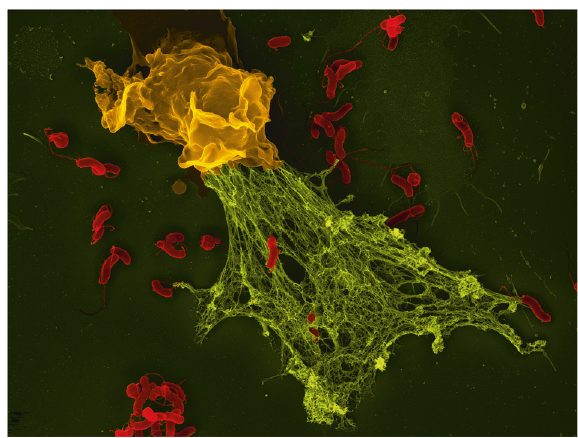
Fig. 2 The neutrophil extracellular trap. A collapsing neutrophil has expelled its web to trap bacteria (Photo and permission by Volker Brinkmann, Max Planck Institute for Infection Biology, Berlin,